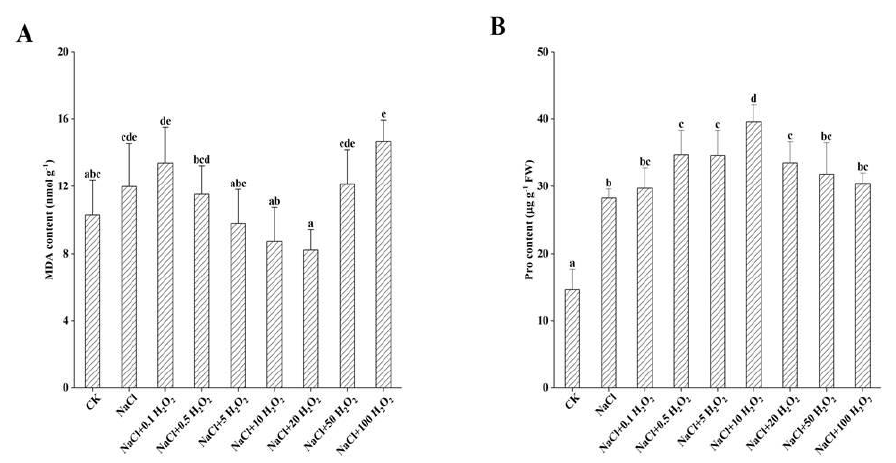
Figure 4. Effect of H 2 O 2 on MDA ( A ) and Pro ( B ) contents of F. tataricum seedlings under NaCl stress. CK, control treatment (only water); NaCl, 50 mmol L −1 NaCl treatment; NaCl + xxx H 2 O 2 , treatments of standard NaCl + respective H 2 O 2 concentration; MDA, malondialdehyde (nmol g −1 ); Pro, proline (µg g −1 FW). Different lowercase letters on each column indicate significant differences between treatments at p < 0.05.